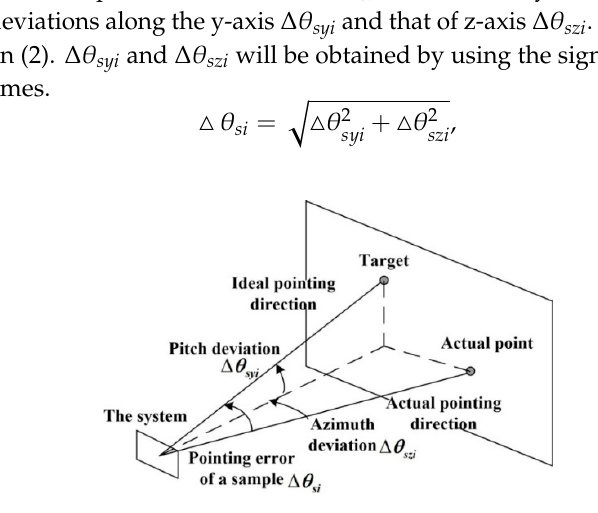
Figure 4. Meaning of pointing error of a sample (cid:52) θ si .